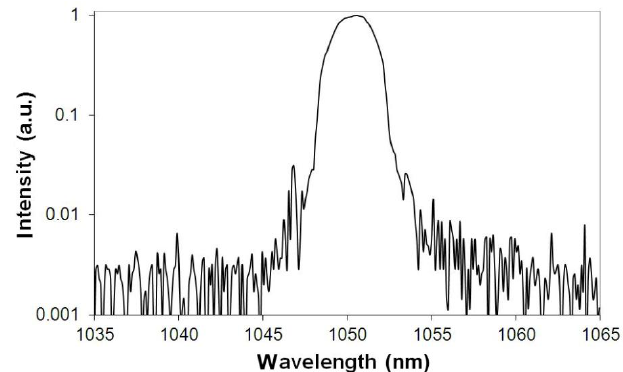
Figure 11. Spectrum of the laser emission at maximum output